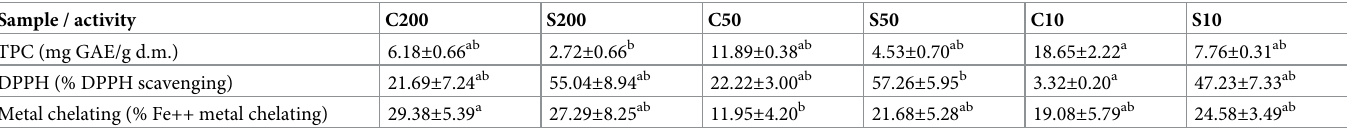
The mean values in the line marked with different small letters indicate the significance of differences ( p �